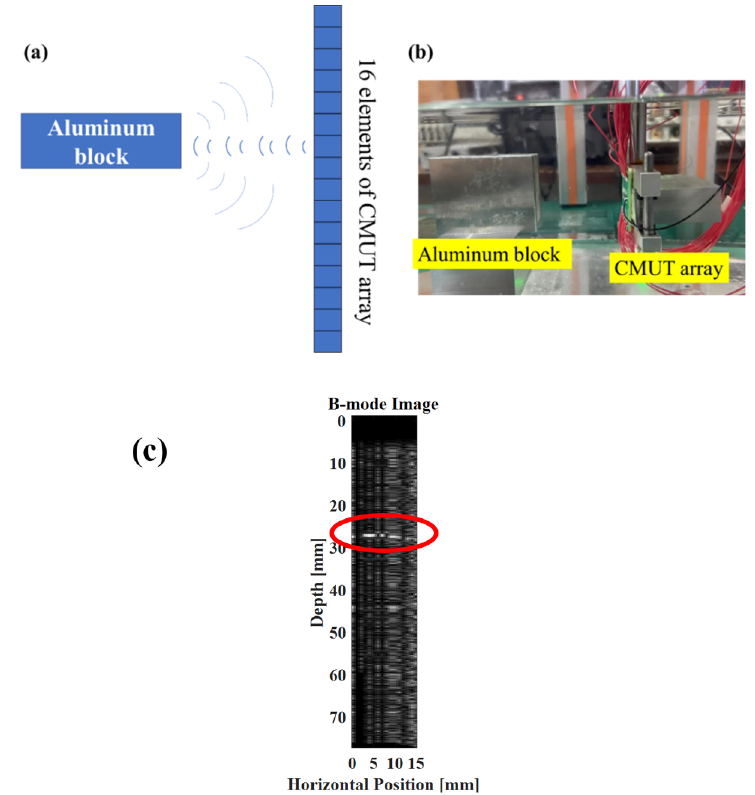
Figure 12. CMUT emission array imaging experiment. ( a ) Schematic diagram of CMUT single line array imaging; ( b ) Photo of the experimental configuration; ( c ) Imaging result: the red circle indicates the first reflective surface of the aluminum block.